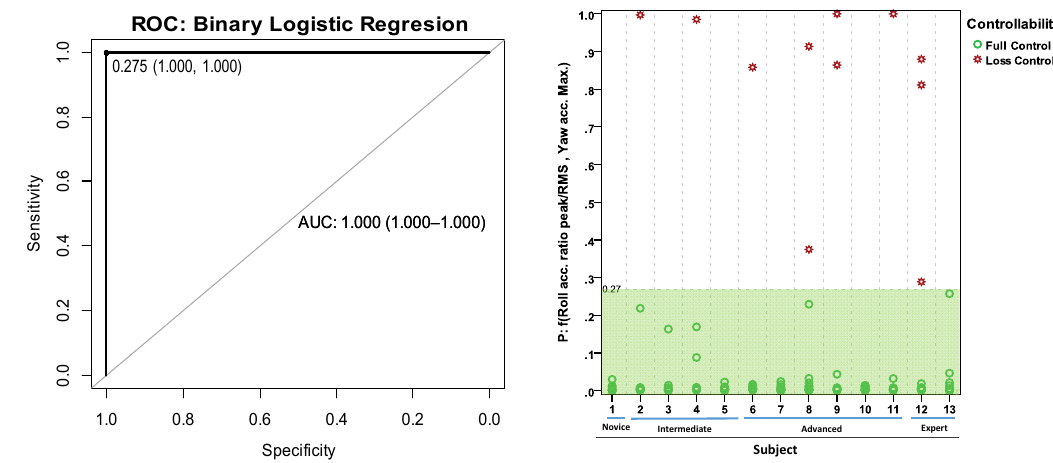
Figure 9. Model-3: ROC and scatter plot of loss of control probability by subject for the 165 braking trials.